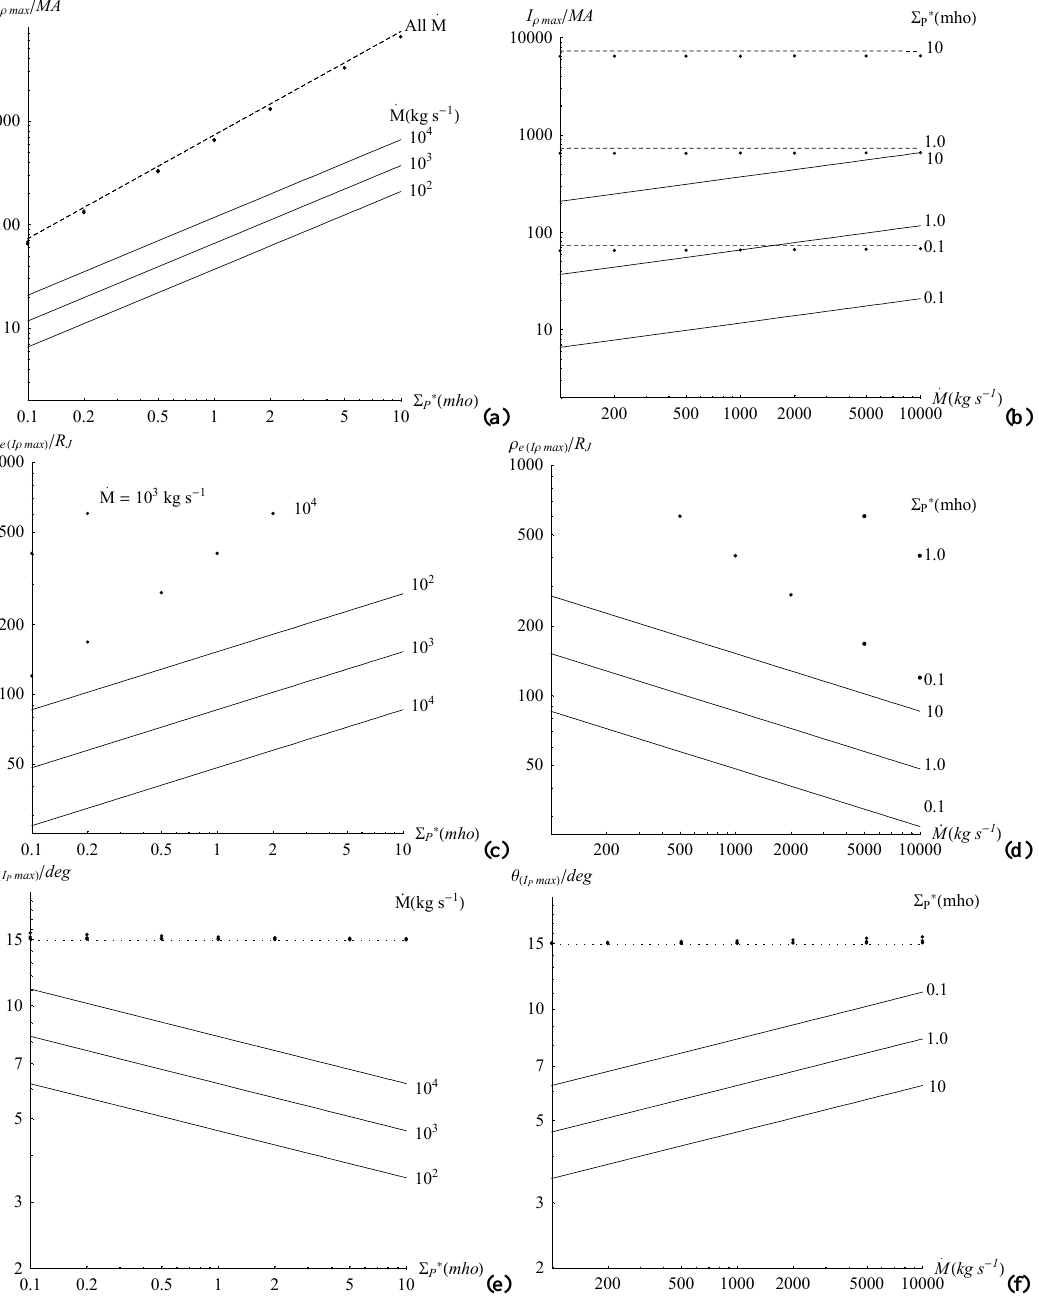
Fig. 11. Plots showing the magnitude and location of the peak azimuth-integrated total equatorial and ionospheric currents, and their dependence on 6 ∗ and ˙ M . Plot (a) shows the magnitude of the peak total equatorial radial current (equal to twice the peak total ionospheric P Pedersen current) versus 6 ∗ in log-log format for ˙ M = 100, 1000 and 10000kgs − 1 , while plots (c) and (e) show the corresponding P equatorial and ionospheric locations of the peak in a similar format. Plots (b) , (d) and (f) similarly show the magnitude and location of = 0 . 1, 1 and 10mho. Solid lines give results for the dipole field obtained from the azimuth-integrated peak total current versus ˙ M for 6 ∗ P Eqs. (21b, d), while the dashed lines show corresponding results derived from the approximate solutions for the power law current sheet model given by Eqs. (34b, d). The peak total current in the latter model is independent of ˙ M , so that only one dashed line is shown in (a). It occurs at infinity in the equatorial plane so that no dashed lines are shown in (c) and (d), or equivalently at the poleward boundary of current sheet field lines in the ionosphere at ∼ 14.95 ◦ as shown in (e) and (f) (dotted line). The solid dots show spot values obtained from numerical integration of the full current sheet solution. In this case the peak values occur at large but finite distances such that only the closest of them are included in (c) and